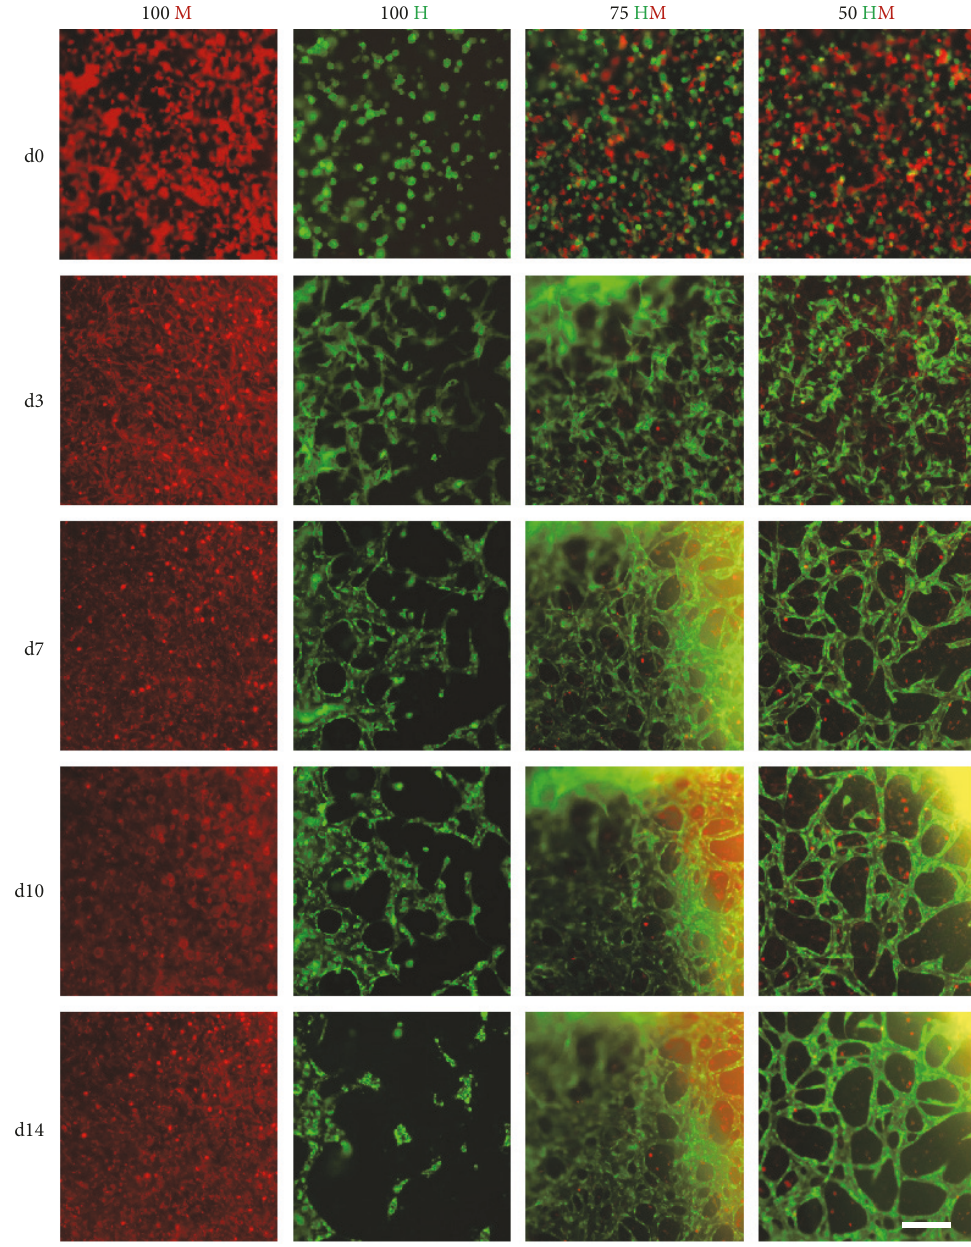
Figure 3: Time-lapse pictures of HUVEC and MSC mono- and cocultures. GFP-positive HUVECs (green) and PKH26 Red prestained MSCs were encapsulated in PRP (seeding density: 2.5 × 10 3 cells/ μ l gel) and time-lapse microscopy ran for two weeks. Four di ff erent cell proportions were seeded: 100% MSCs (100M, fi rst column), 100% HUVECs (100H, second column), 75% HUVECs – 25% MSCs (75 HM, third column), and 50% HUVECs – 50% MSCs (50 HM, fourth column). Representative pictures of fi ve time points are shown: day 0 (d0), day 3 (d3), day 7 (d7), day 10 (d10), and day 14 (d14). Cellular organization towards formation of tube-like networks starting from day 3 was observed in mono- and cocultures in PRP over time but not in the condition of 100% MSCs. After one week, a complex cellular network could be detected in both cocultures which was still apparent after two weeks. Cellular networks in HUVEC monocultures disintegrated after 10 days. Scale bar =200 μ